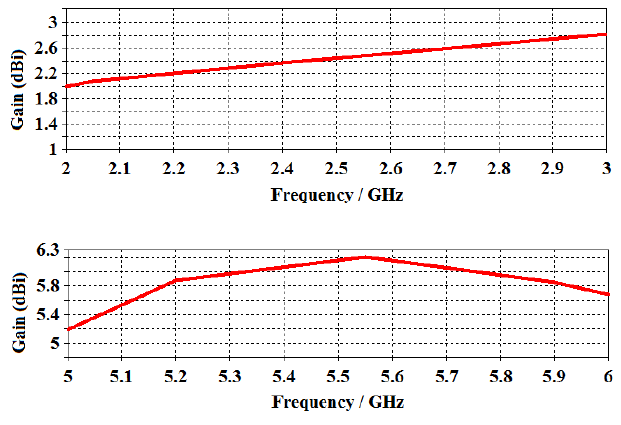
Figure 17. Computed peak gains of the proposed antenna throughout the lower and the upper resonant